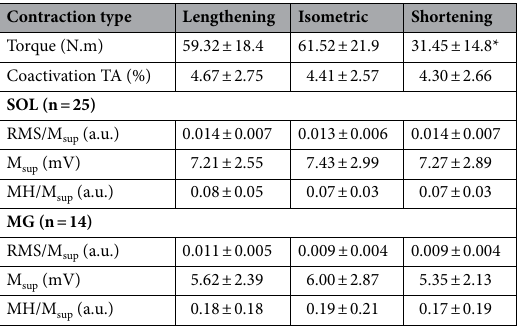
Table 1. Effect of contraction type on torque, coactivation, plantar flexors EMG activity, and on amplitudes of soleus (SOL) and medial gastrocnemius (MG) evoked potentials. Data are means ± SD. *p < 0.001: shortening vs isometric and lengthening.